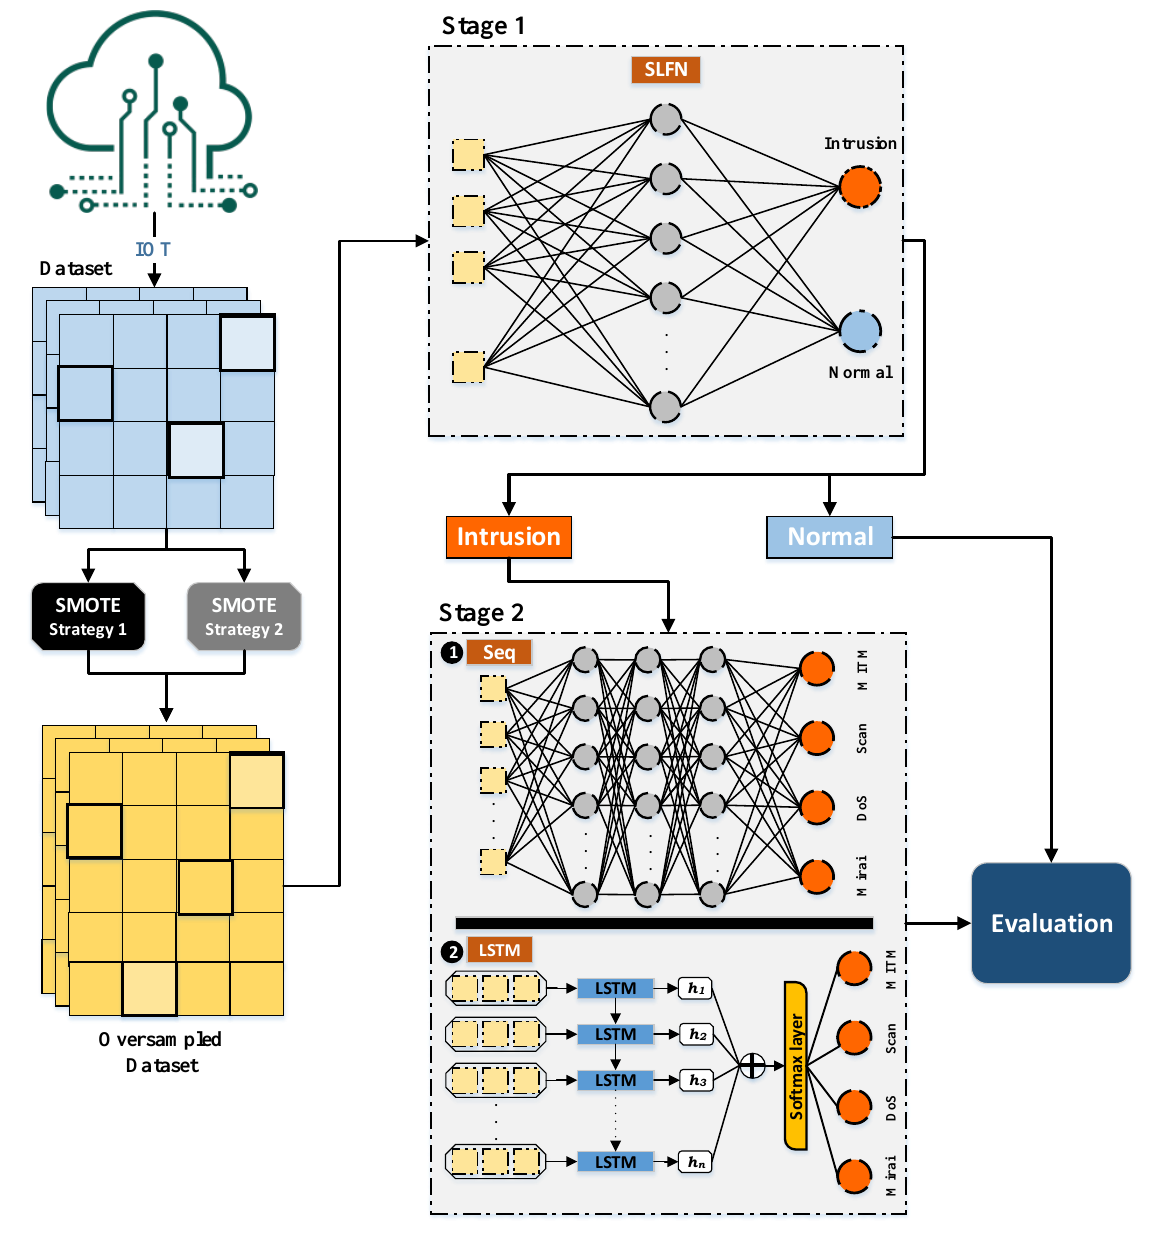
Figure 4. The proposed multi-layer classification